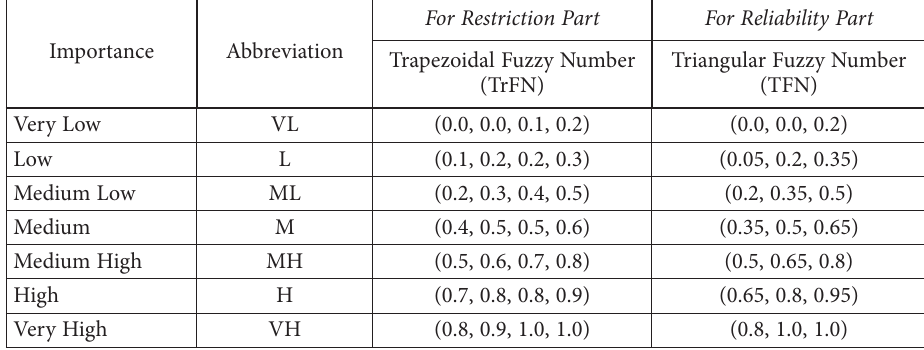
Table 3. Fuzzy linguistic terms and correspondent fuzzy numbers of each